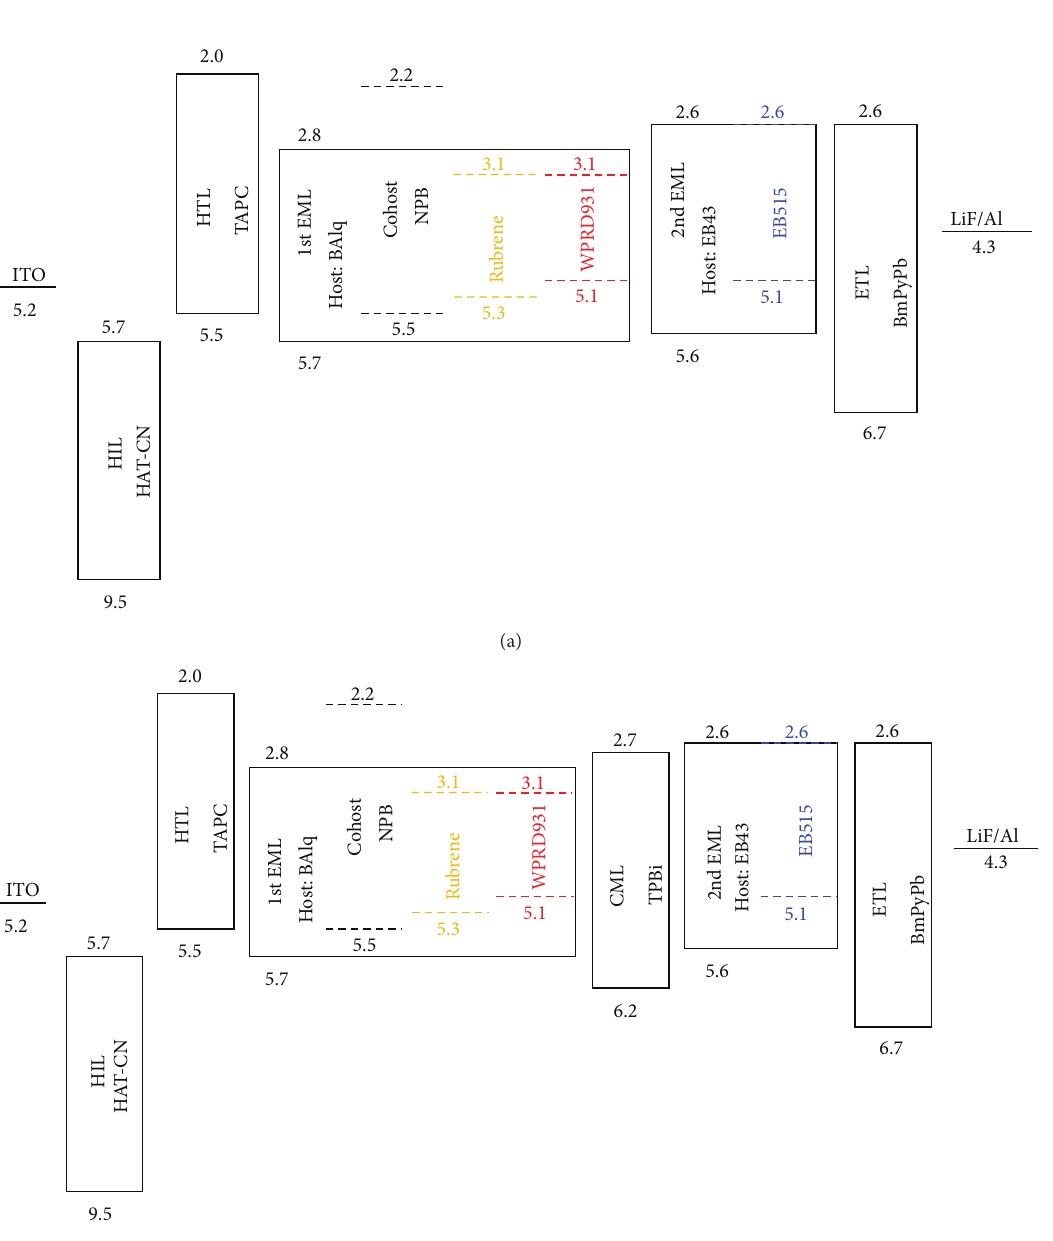
Figure 1: Schematic illustrations of the device structure, in terms of energy-levels, of the color temperature tunable OLED devices composing three black body radiation complementary emitters, namely, red, yellow, and blue, dispersed in two emissive layers (EMLs) (a) without any hole modulation layer, and (b) with an extra nanoscale hole modulating layer with an energy barrier of 0.7eV at the interface between the orange and blue EMLs. Nevertheless, there still exists a 0.2 eV hole injection barrier in Device (a) between the hole transporting layer and the host of the first EML, which could hence effectively regulate the injection of hole and in turn the shifting of recombination